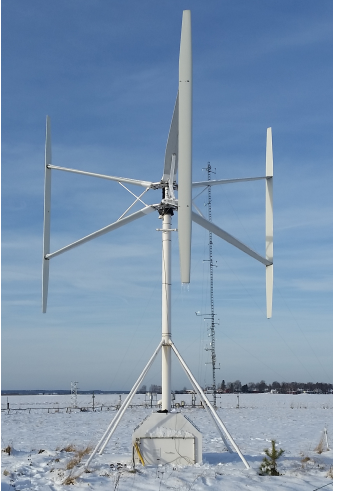
Figure 1. The turbine